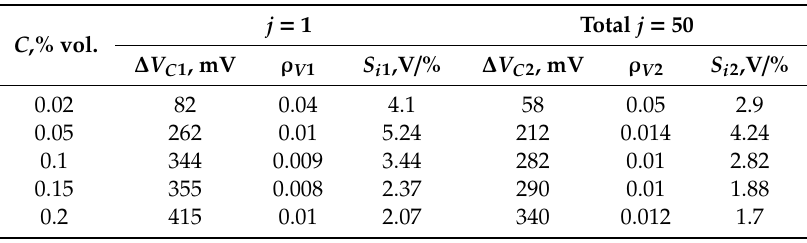
Table A1. The average values of response amplitude ∆ V Ci and its parameters for the first and fiftieth j